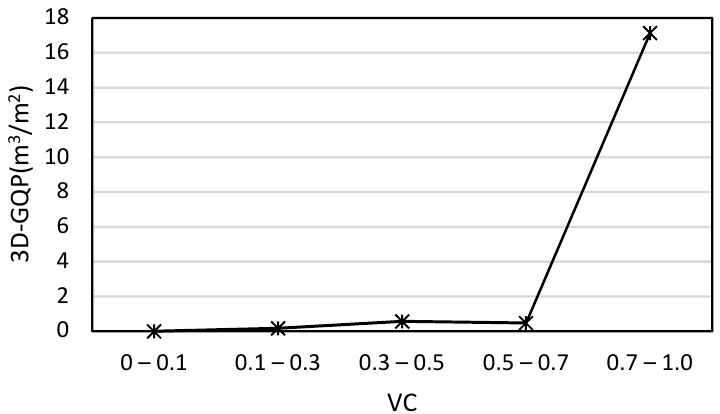
Figure 10. The relation graph between VC and 3D-GSQP.